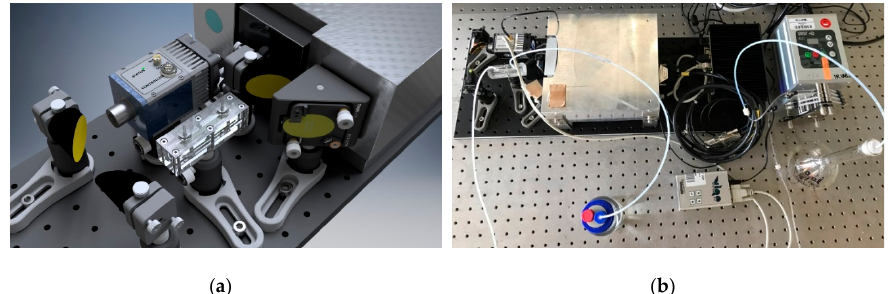
Figure 3. ( a ) Schematic of the experimental setup showing the respective components, FT-IR (Fourier transform infrared) spectrometer, coupling optics, thermoelectrically-cooled MCT detector, and µ -flow cell. The latter included the waveguide element (i.e., AgX fiber). ( b ) Entire miniaturized MIR sensor system (size: 650 × 210 mm 2 ) comprising of the optical components, a small computer for data generation and analysis, and a peristaltic pump.